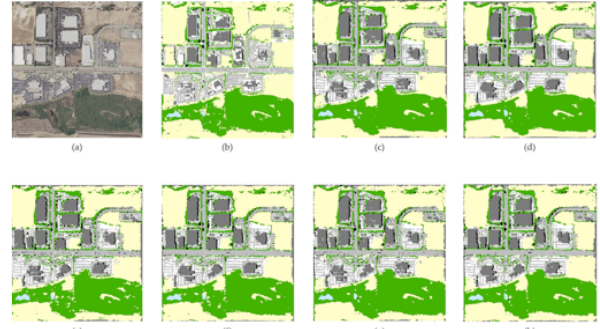
Figure 10. Classification result comparison of different methods for Suburban scene. (a) Original image (b) OBIA-SVM; (c) Per- pixel SCNN; (d) Per-pixel MCNN; (e) SLICO based SCNN; (f) SLICO based MCNN; (g) SEEDS based SCNN; (h)SEEDS